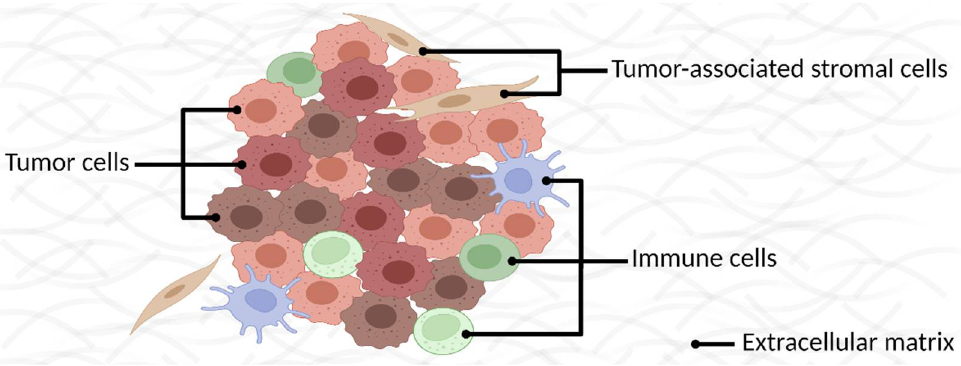
Figure 5 . A schematic representation of a generic tumor microenvironment with different cell types .